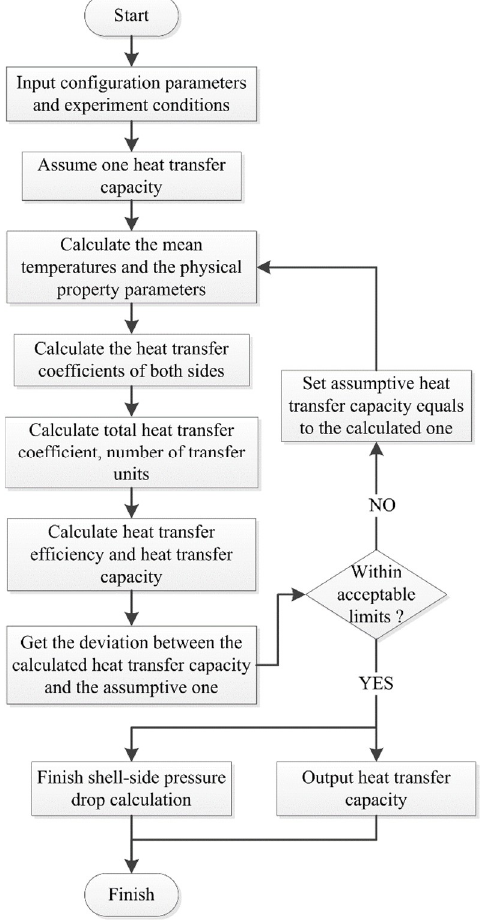
Figure 2. Flowchart of the thermohydraulic calculation model.